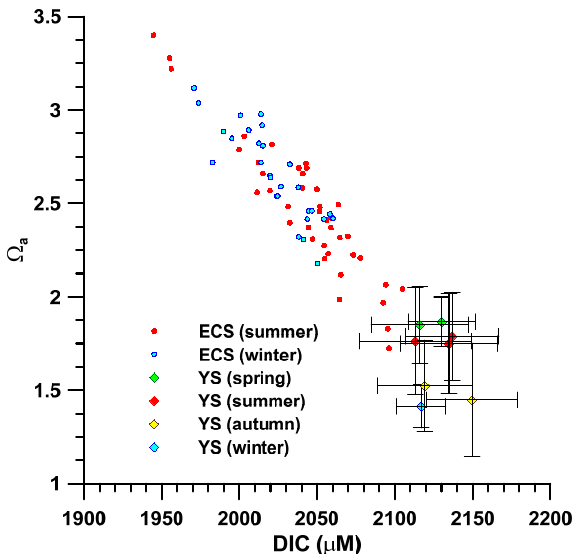
Figure 3. Aragonite saturation ( a ) vs. DIC in the bottom waters of the ECS (Chou et al., 2013b) and the YS (Zhai et al., 2014). The data points of the YS are areal mean values from each cruise. The trend indicates the lowering of aragonite saturation in correspondence to increasing accumulation of DIC from respiration.